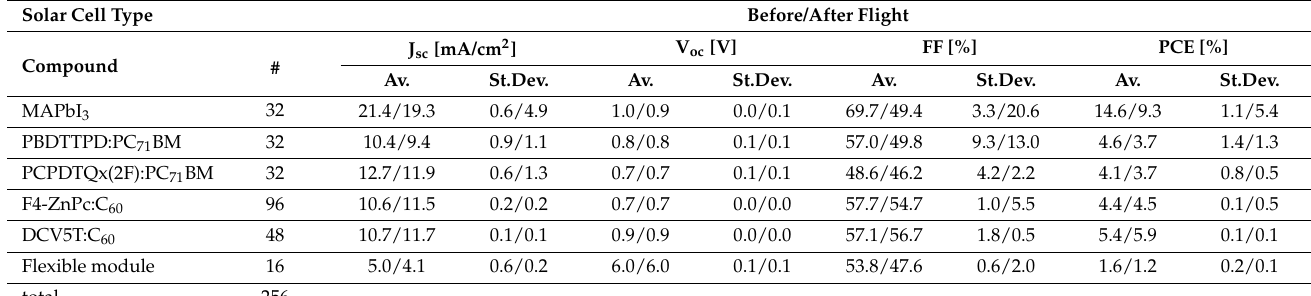
Table 7. Summary of different solar cells and their average performance parameters before and after flight, as measured under an AM1.5G simulated solar spectrum with an irradiance of 1000 W/m 2 (only working devices were re-measured: the number of devices included in the statistics is lower for the after flight measurements than for the before flight measurements). Since measurements were carried out in different laboratories, testing conditions might slightly vary. Due to both the lack of solar simulators at the launch site and the need for early shipment of the samples, the measurements correspond to a few months before flight and a few weeks after flight. Copyright permission from